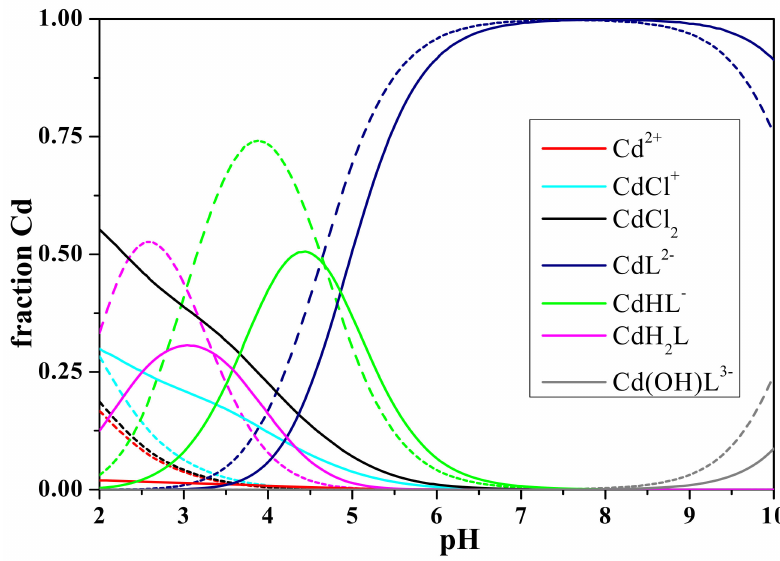
Figure 2. Speciation diagram of the Cd 2+ / Glda 4 − system is given at low ionic strength ( I = 0.05 mol kg − 1 , dashed line) and at ionic strength of seawater ( I = 0.72 mol kg − 1 , solid line) at T = 298.15 K and p = 0.1 MPa. Experimental conditions: C Cd = 10 − 5 mol kg − 1 ; C L = 10 − 3 mol kg − 1 . Species: Cd 2+ (red), CdCl + (cyan), CdCl 20 (aq) (black), CdL 2 − (navy), CdHL − (green), CdH 2 L 0 (aq) (magenta), Cd(OH)L 3 −